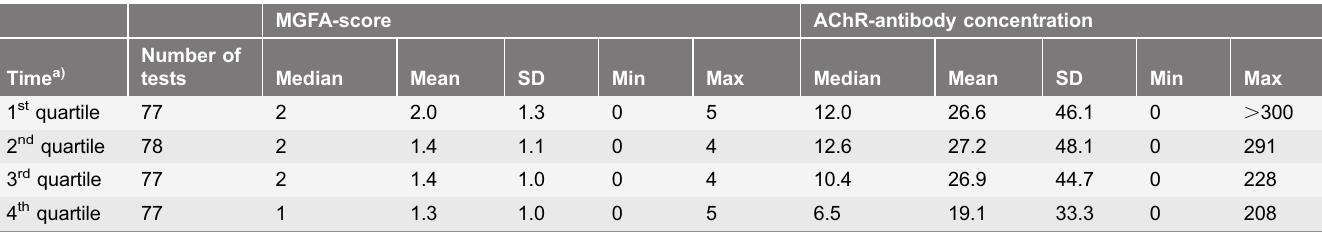
Table 4. Descriptive statistics for MGFA-score (1–5) and AChR-antibody concentration (nmol/L) in each quartile of time since onset for 309 tests of 67 MG patients at Haukeland University Hospital, Bergen, Norway 1983–2013.